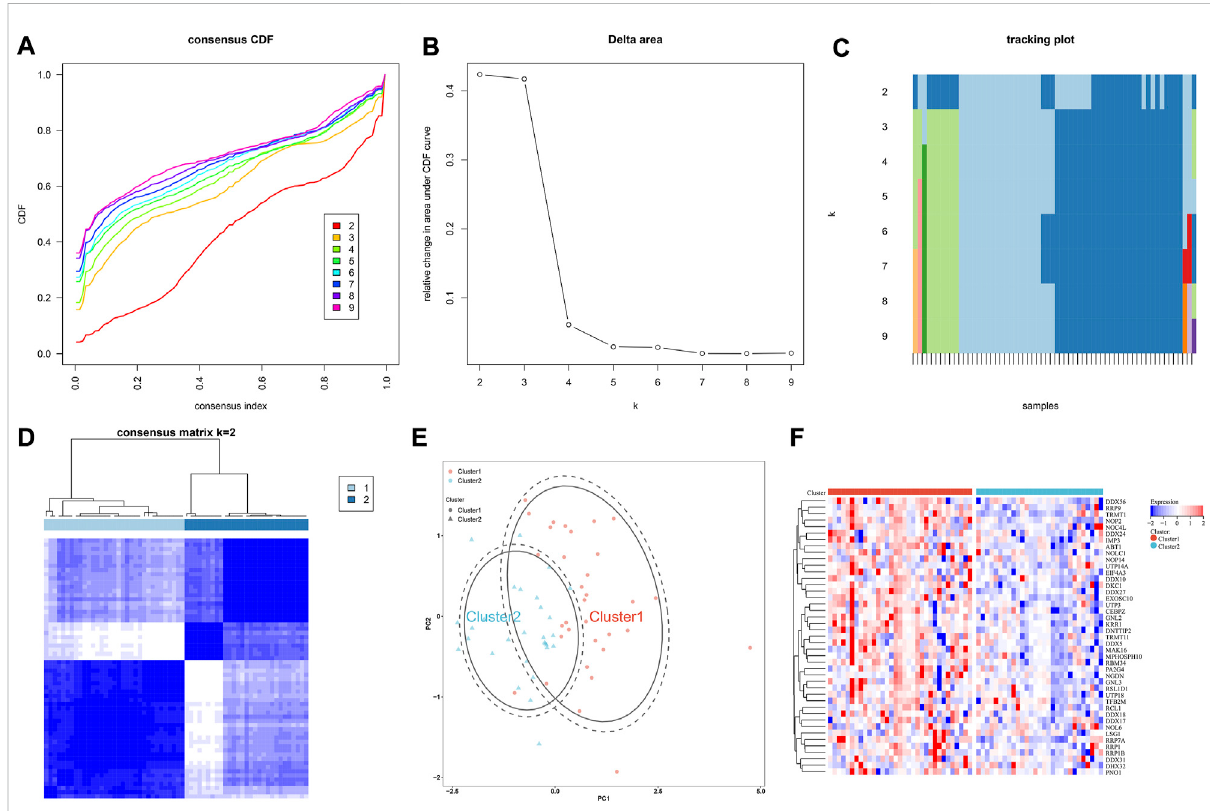
FIGURE 6 IgA nephropathy is classi fi ed as two subtypes based on hub RBPs. (A) The consensus CDF across different k values. (B) Delta area plot for the relativechangeintheareaundertheCDFcurves. (C) Trackingplotfortheitemclustermembershipacrossdifferentkvalues. (D) Consensusmatrixat k = 2. (E) PCA plot of two subtypes. (F) Expression of hub RBPs in two